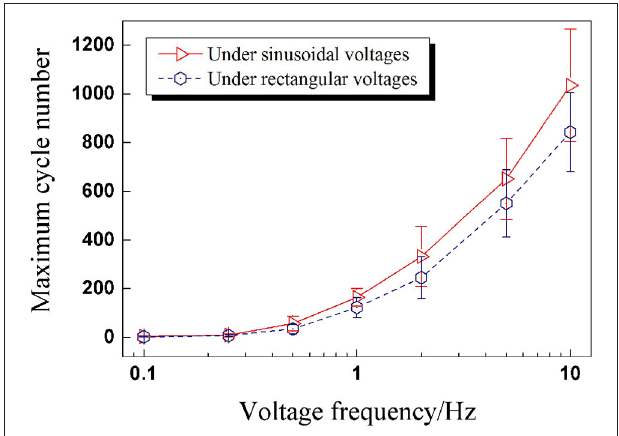
FIGURE 8 | Maximum cycle numbers before breakdown under sinusoidal voltage with different peak voltages.